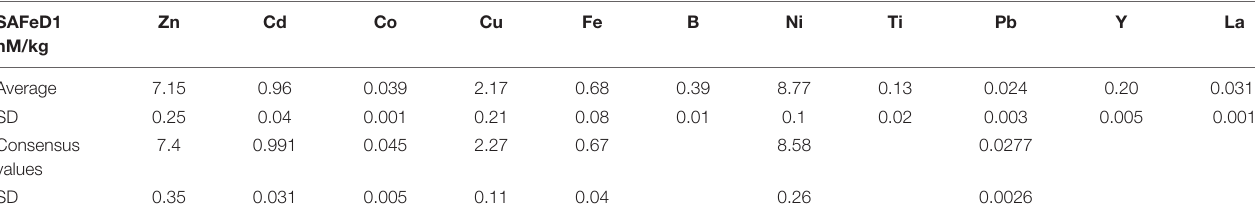
TABLE 1 | The values of SAFe reference sample D1 for trace metals measured by ICPMS and the 2013 consensus values for some metals, in